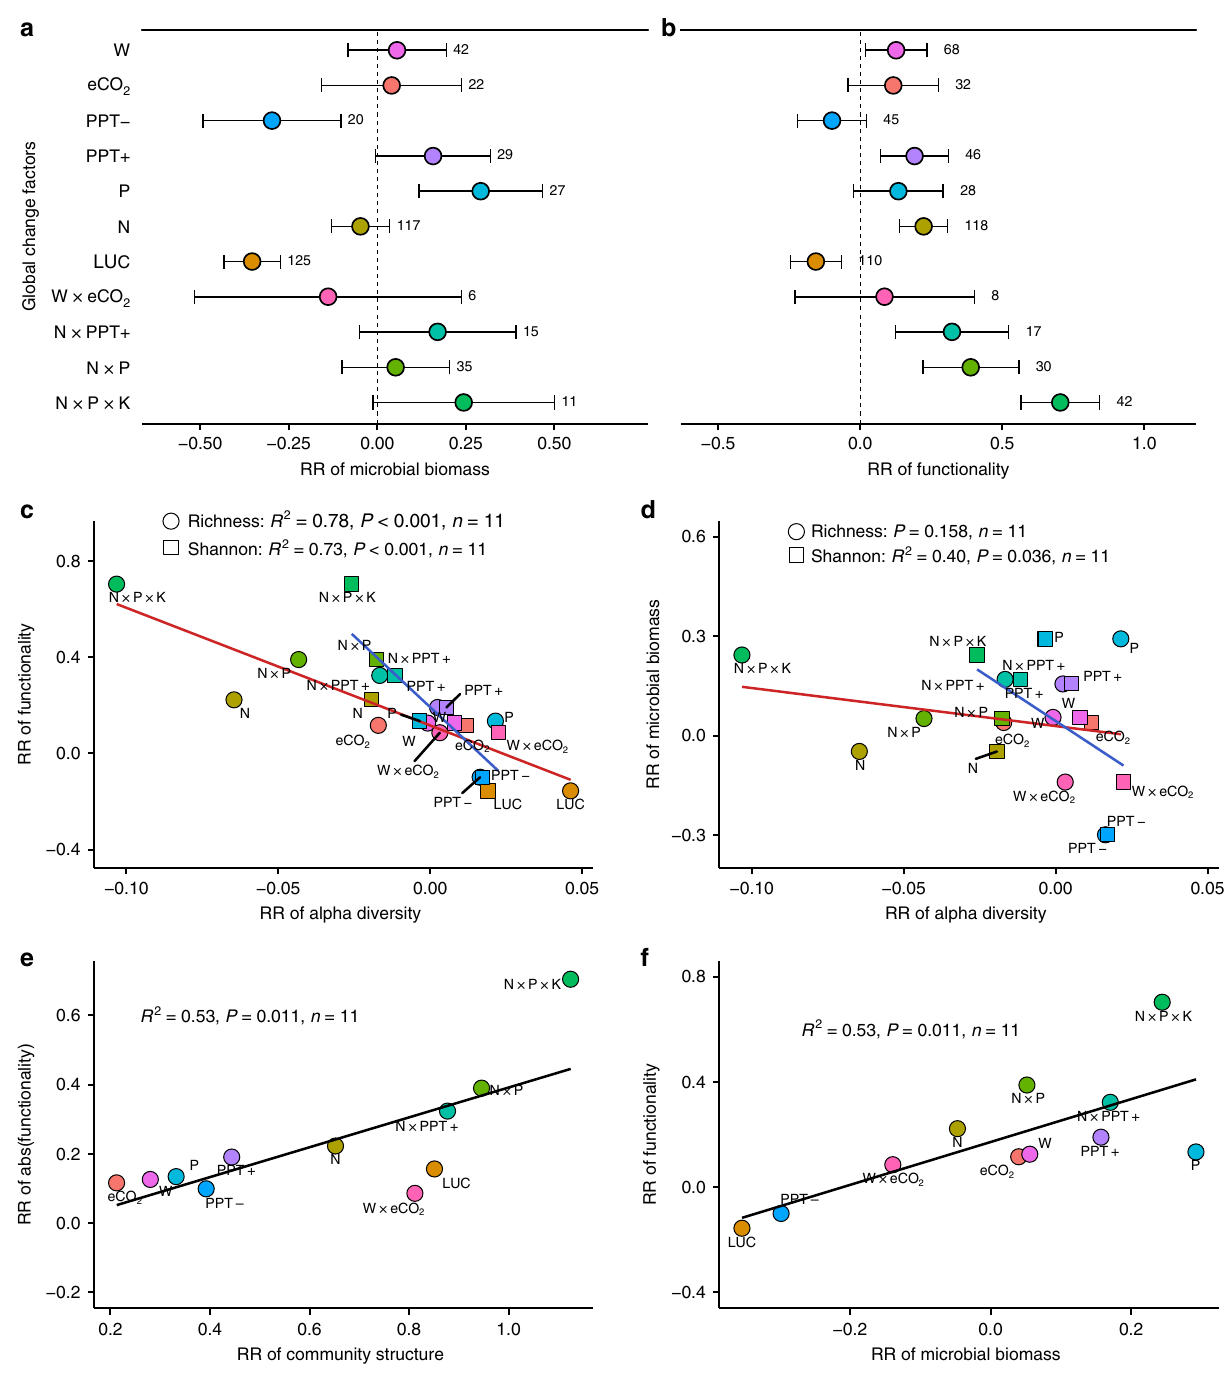
Fig. 5 Global changes affect microbial biomass and functionality associated with diversity. a Response ratio (RR) of microbial biomass to global change factors (GCFs). b RR of microbial functionality to GCFs. Weighted means and their 95% con fi dence intervals of RRs are given. The numbers at the right side of the con fi dence intervals represent the sample sizes. c Linear relationships between RR of microbial functionality and RRs of richness ( y = − 4.89 x + 0.12) and Shannon index ( y = − 11.80 x + 0.19). d Linear relationships between RR of microbial biomass and RRs of richness (insigni fi cant) and Shannon index ( y = − 7.83 x + 0.02). e Linear relationship between RR of absolute value (abs) of microbial functionality and RR of microbial community structure ( y = 0.43 x − 0.04). The absolute value is used because we assume that great change in microbial community structure would result in great change (both increase or decrease) in functionality and the community structure can not be quanti fi ed as increasing or decreasing. f Linear relationship between RR of microbial functionality and RR of microbial biomass ( y = 0.82 x + 0.17). W warming, eCO 2 carbon-dioxide enrichment, PPT − decreased precipitation, PPT + increased precipitation, P phosphorous addition, N nitrogen addition, LUC land-use change, W × eCO 2 warming plus carbon-dioxide enrichment, N × PPT + nitrogen addition plus increased precipitation, N × P nitrogen plus phosphorous addition, N × P × K nitrogen plus phosphorous plus potassium addition. Source data are provided as a Source Data fi